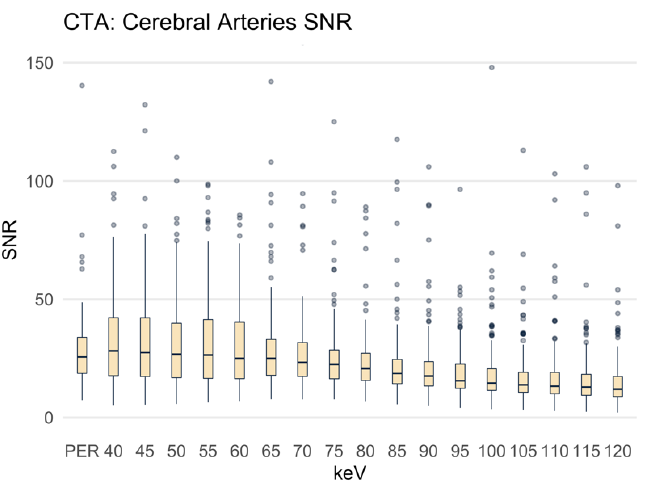
Figure 5. Signal-to-noise ratio presented as boxplots. PER: polyenergetic reconstruction; keV: keV level of the monoenergetic reconstruction. Cerebral arteries: ACA, MCA and PCA.